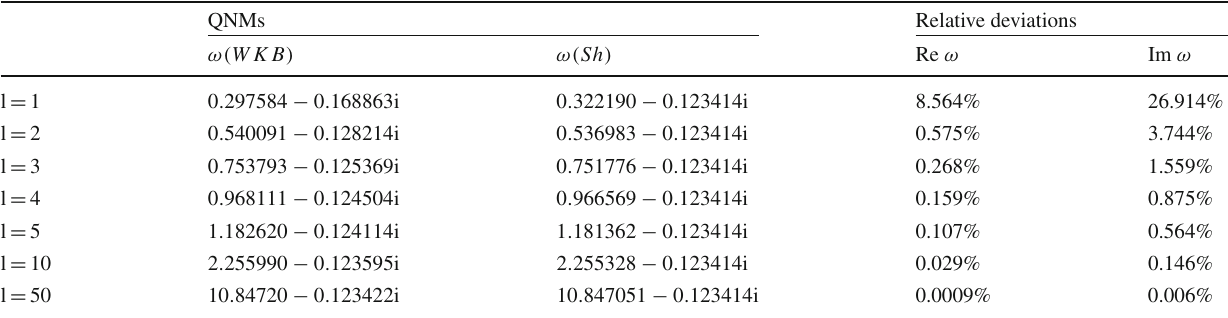
Table 12 The QNMs derived by the WKB approximation approach and shadow radius and the relative deviations. In the calculation, we let Q = 1 and α = − 1